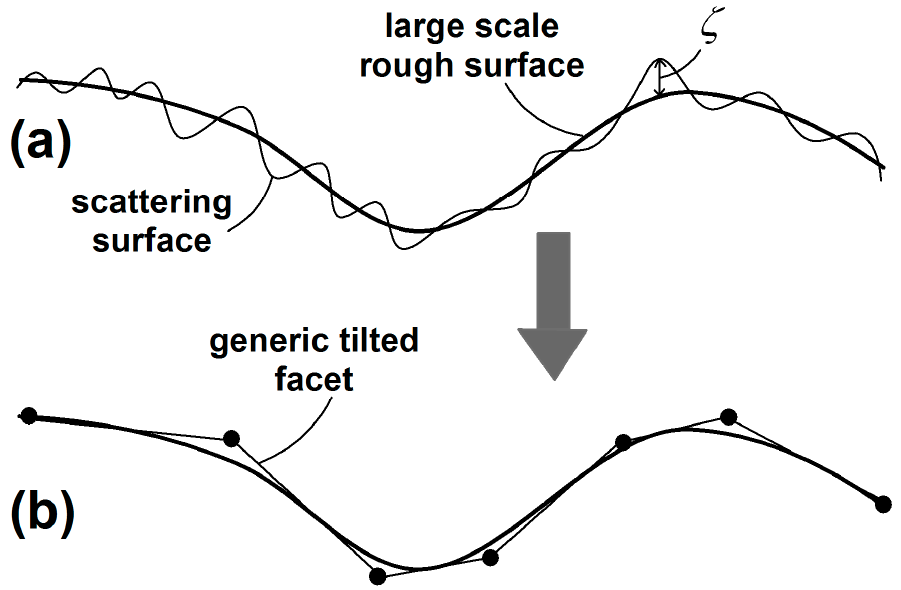
Figure 1. Polarimetric Two-Scale Model (PTSM) surface representation: from actual surface ( a ) to its approximation by facets ( b ).